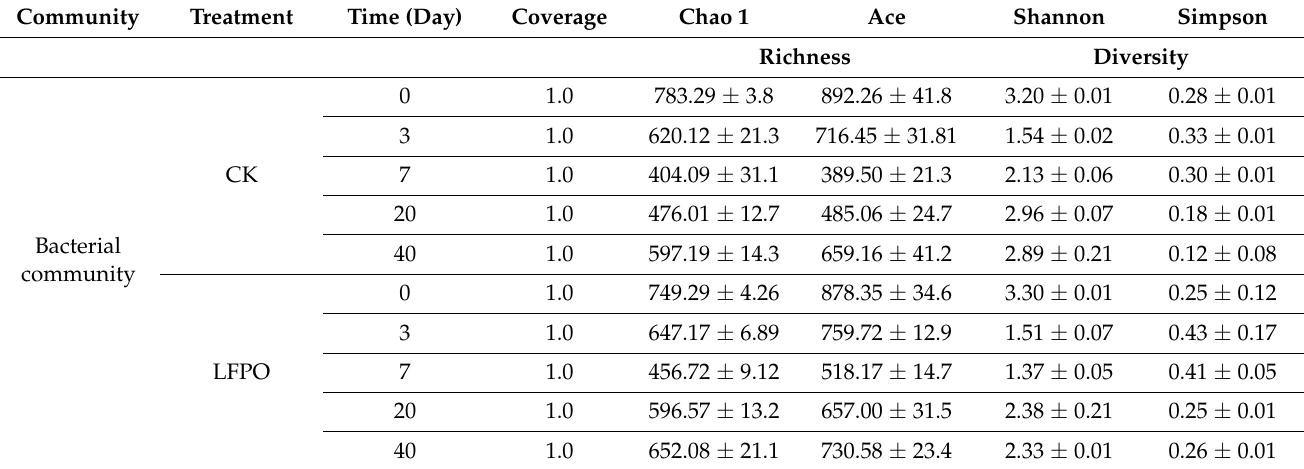
Table 4. Alpha diversity of the microbial structures in